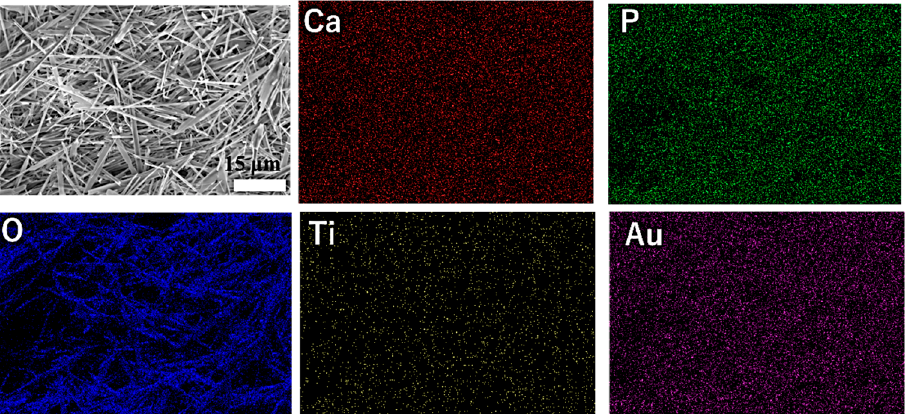
Figure 8. FE-SEM micrograph showing the surface of the TiO 2 -coated HAp membrane following Au nanoparticle separation and EDX element mapping to detect, in particular, the captured Au nanoparticles.